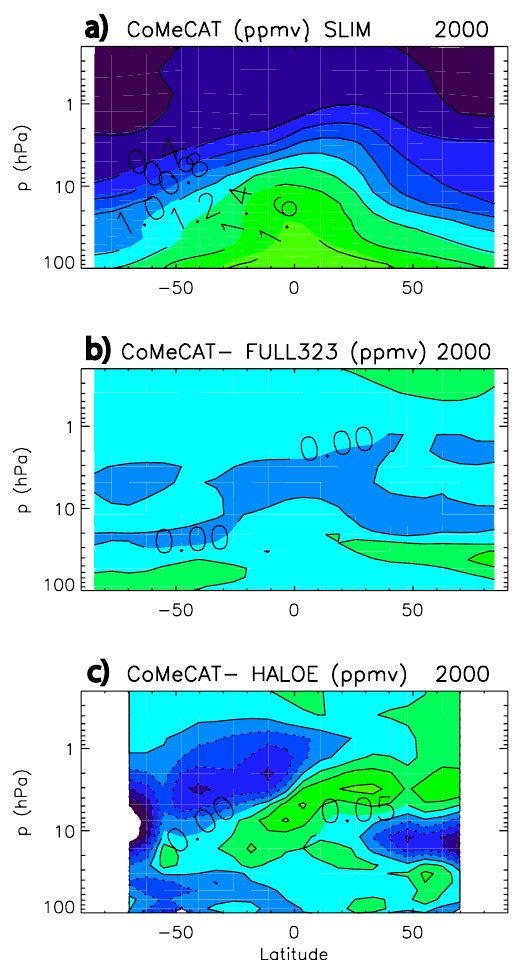
Fig. 5. Annual mean for year 2000 of (a) zonally averaged CH 4 distributions (ppmv) from the CoMeCAT scheme in the CTM run13, (b) differences between CoMeCAT and full-chemistry run of SLIMCAT (run323) and (c) differences between CoMeCAT and HALOE observations. The model simulations use ERA-40 winds. Contour values are 0.20ppmv for (a) and 0.05ppmv for (b) and (c) . Colour scale in (a) goes from larger concentrations (darkest green) to smaller concentrations (darkest blue), while for (b) and (c) the colour scale indicates most positive differences (in darkest green) and most negative differences (in darkest blue). HALOE observa- tions are available for the latitudinal range 80 ◦ S–80 ◦